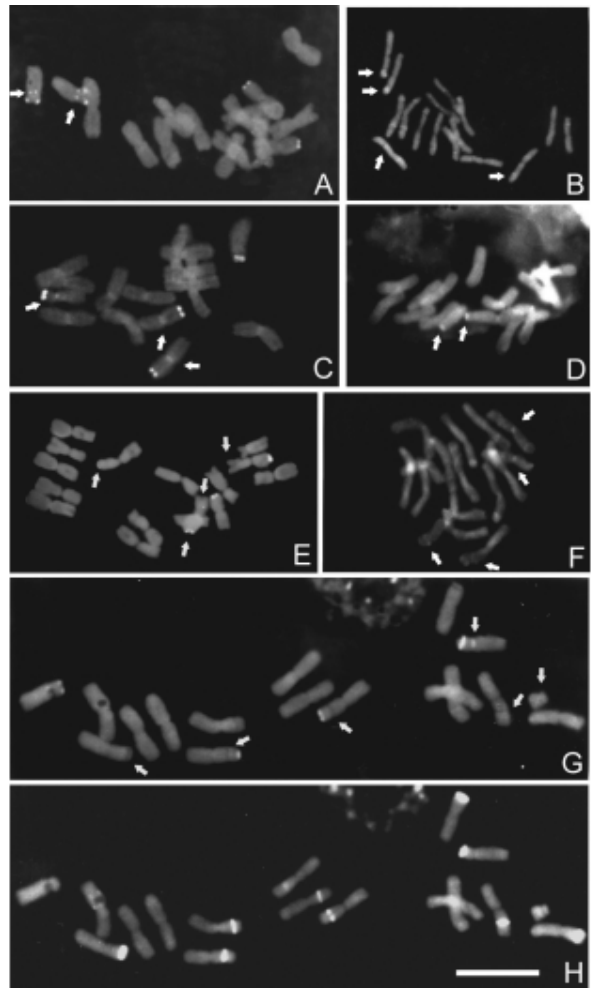
Figure 2 - Chromosome banding with fluorochromes in Cestrum species. (A) C-CMA 3 banding in C. amictum , arrows indicate the minor and proxi- malbandinthepair8.(B)C-DAPIbandingin C.amictum ,arrowsindicate minor and interstitial bands. (C) C-CMA 3 banding in C. intermedium , ar- rows indicate inconstant centromeric-pericentromeric bands and minor and proximal band in the pair 8. (D) C-DAPI banding in C. intermedium , arrows indicate major terminal bands. (E). C-CMA 3 banding in C. sendtnerianum , arrows indicate minor and terminal bands. (F) C-DAPI banding in C. sendtnerianum , arrows indicate some proximal, terminal and interstitial bands. (G) C-CMA 3 banding in C. strigilatum , arrows indi - cate interstitial, proximal (pair 8) bands and a B-chromosome. (H) C- DAPI banding in C. strigilatum , arrows indicate minor interstitial bands and a B-chromosome. Bar represents 10 (cid:1) m.